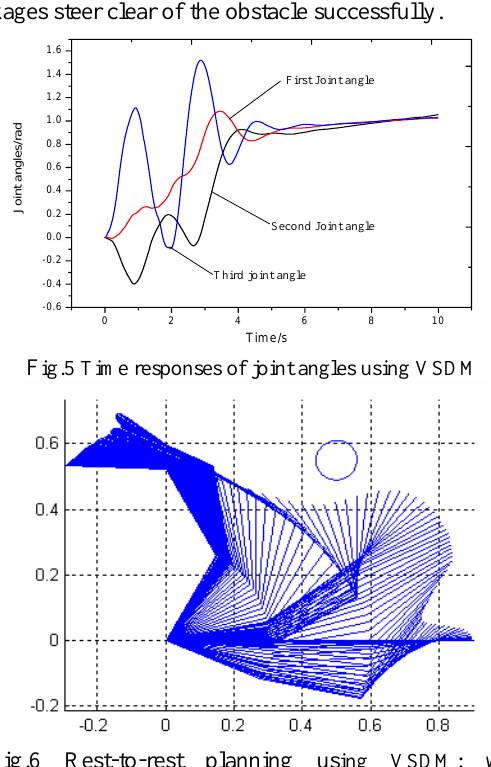
Fig.5 and Fig.6 are the simulation results using virtual spring-damper method. Fig.5 shows the values of joint angles. The final joint angles are (1.042, 1.022, 1.025) rad which are very close to the desired value. Fig.6 is the motion diagram of underactuated system when there are obstacles and it is obviously that the linkages steer clear of the obstacle successfully.